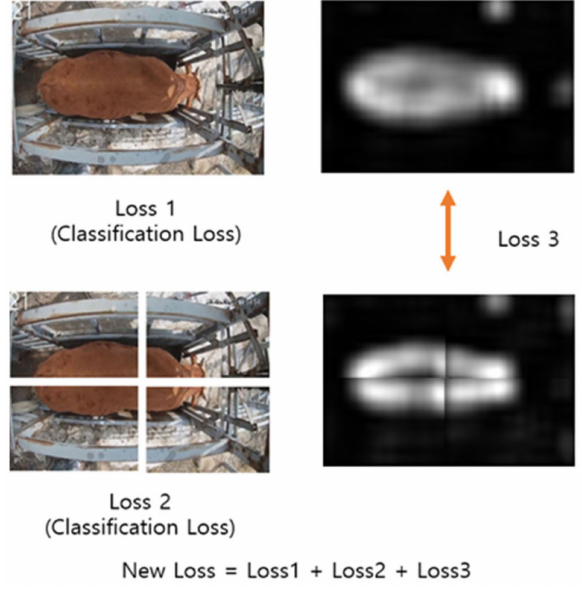
Figure 9. Puzzle-CAM loss.